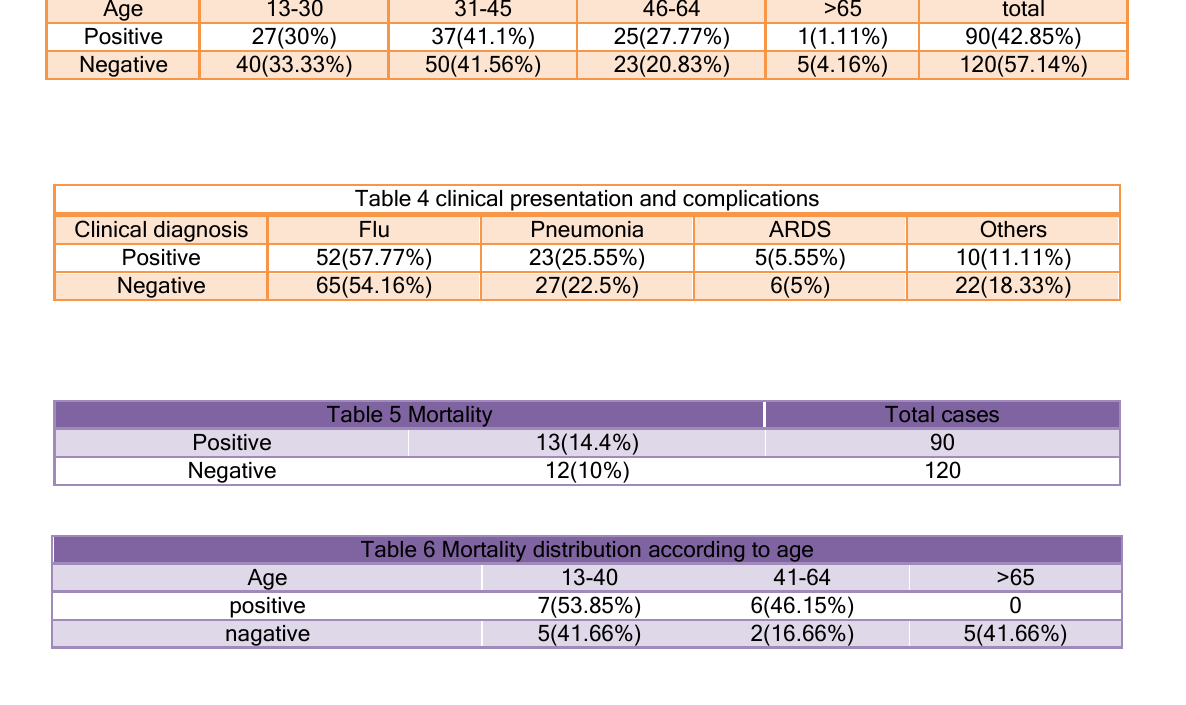
Table 3 Age distribution